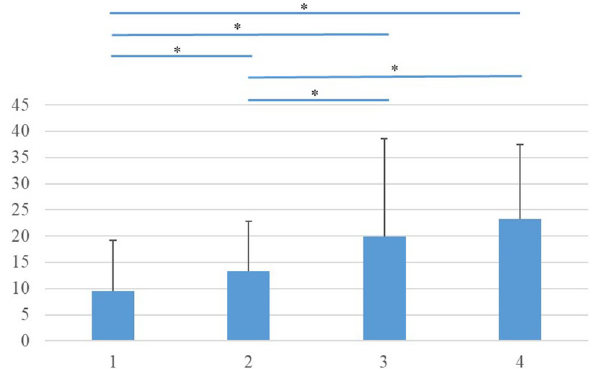
Figure 2. Oswestry Disability Index (ODI) among groups. There were significant differences between Groups 1 and 2, Groups 1 and 3, Groups 1 and 4, Groups 2 and 3, and Groups 2 and 4. p value < 0.001 by ANOVA. * < 0.05 according to Tukey test as post-hoc analysis. Group 1: PT < 20° and SVA < 40 mm; Group 2: PT ≥ 20° and SVA < 40 mm; Group 3: PT < 20° and SVA ≥ 40 mm; Group 4: PT ≥ 20° and SVA ≥ 40 mm.